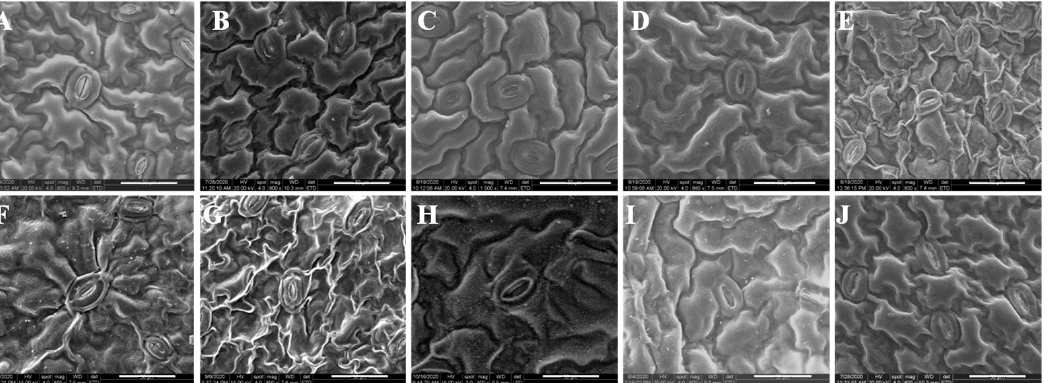
Figure 5. Characteristics of the abaxial epidermal cells under scanning electron microscope. ( A ) P. qiui ; ( B ) P. decomposita ; ( C ) P. jishanensis ; ( D ) P. ostii ; ( E ) P. delavayi ; ( F ) P. lutea ; ( G ) P. potanini ; ( H ) P. rockii ; ( I ) P. ludlowii ; ( J ) P. cathayana . (bar = 50 μ m).